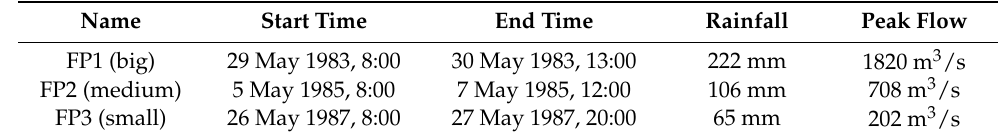
Table 2. The three typical flood processes.